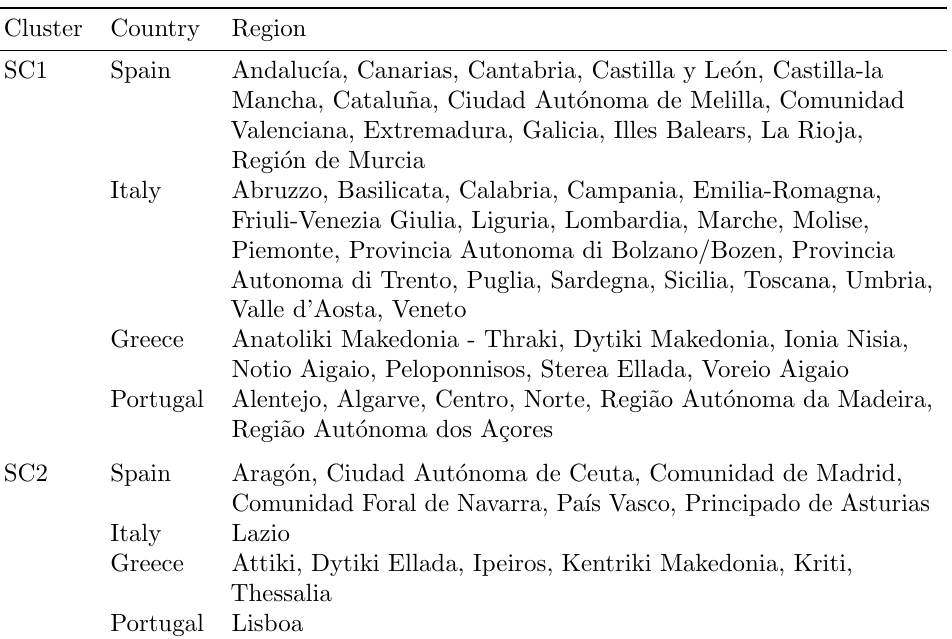
Table A.4: Clustering based on Health and Education characteristics of the south European regions